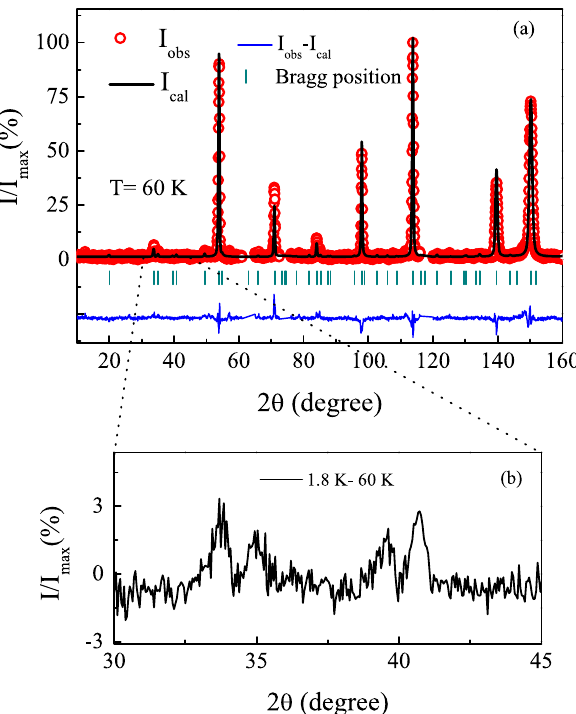
Figure 11. (a) Powder neutron diffraction data at 60 K fitted using full-Rietveld analysis with (cid:31) = 2.4395 Å . Diffraction peaks due to aluminium sample holder are excluded. (b) Magnetic peaks in a selected region as found in the spectra measured at 1.8